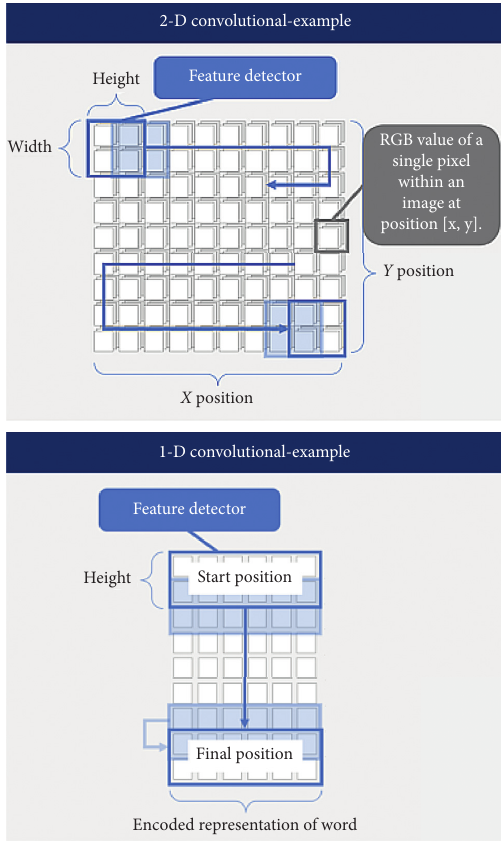
Figure 4: Working mode of 1-D CNN and 2-D CNN.